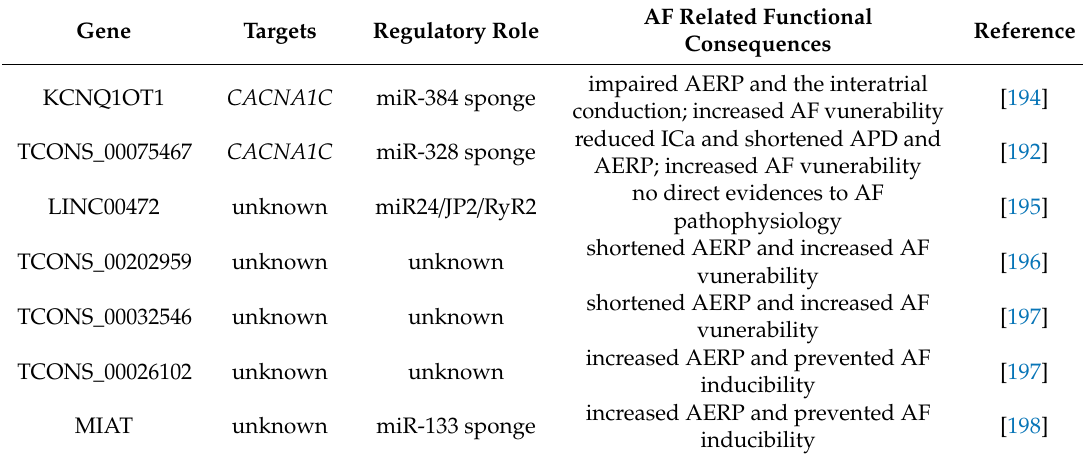
Table 4. AF associated lncRNAs and their functional consequences in AF